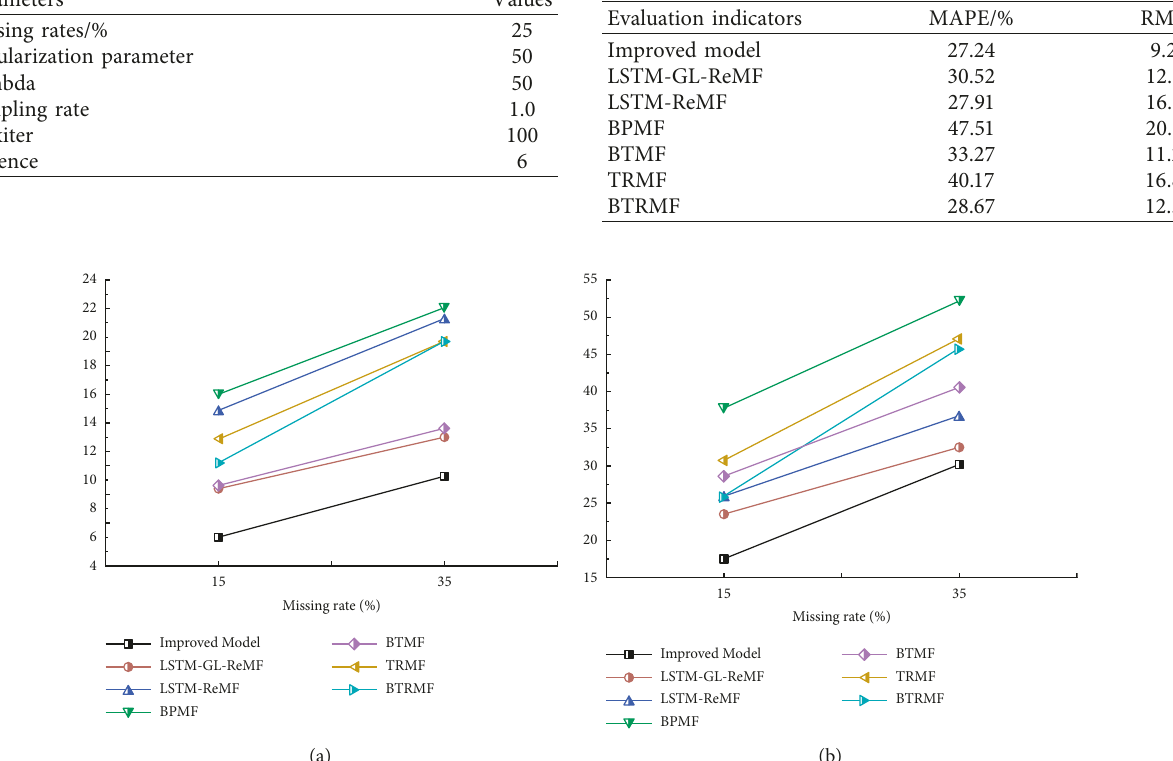
Figure 5: Model evaluation for different absence rates. (a) RMSE. (b) MAPE (%).